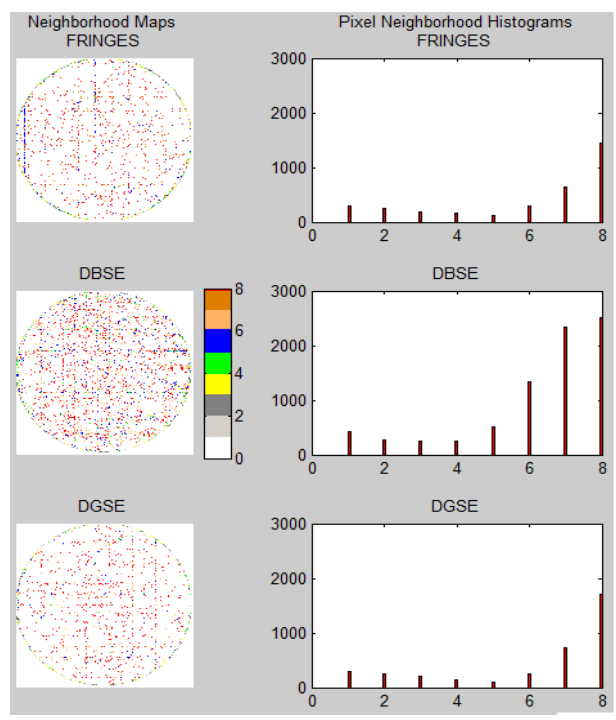
Figure 9. PNMs and histograms for the calibration methods discussed in Figure